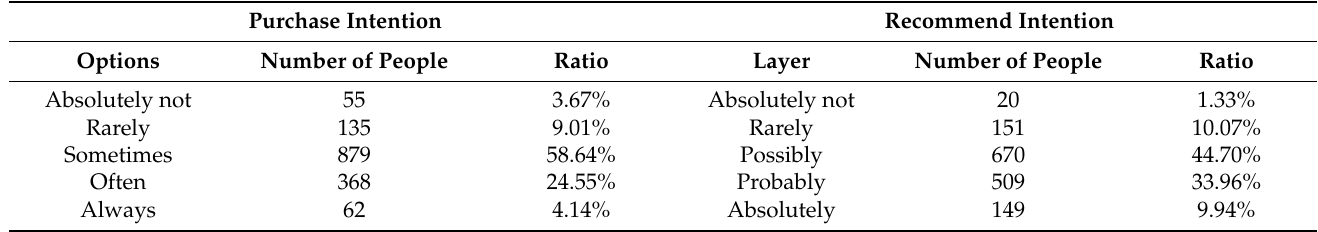
Table 1. Consumers’ behavioral intentions regarding farm animal welfare